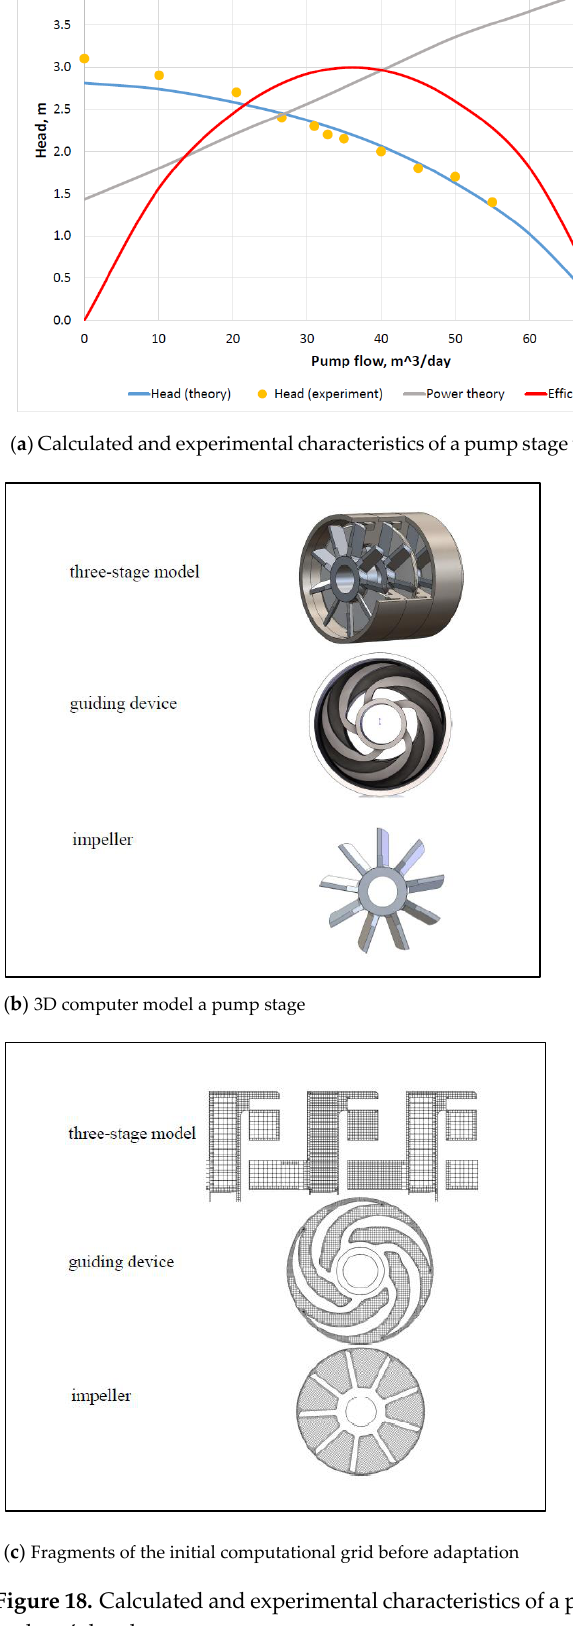
Figure 18. Calculated and experimental characteristics of a pump stage with an open impeller. Source: authors’ development.